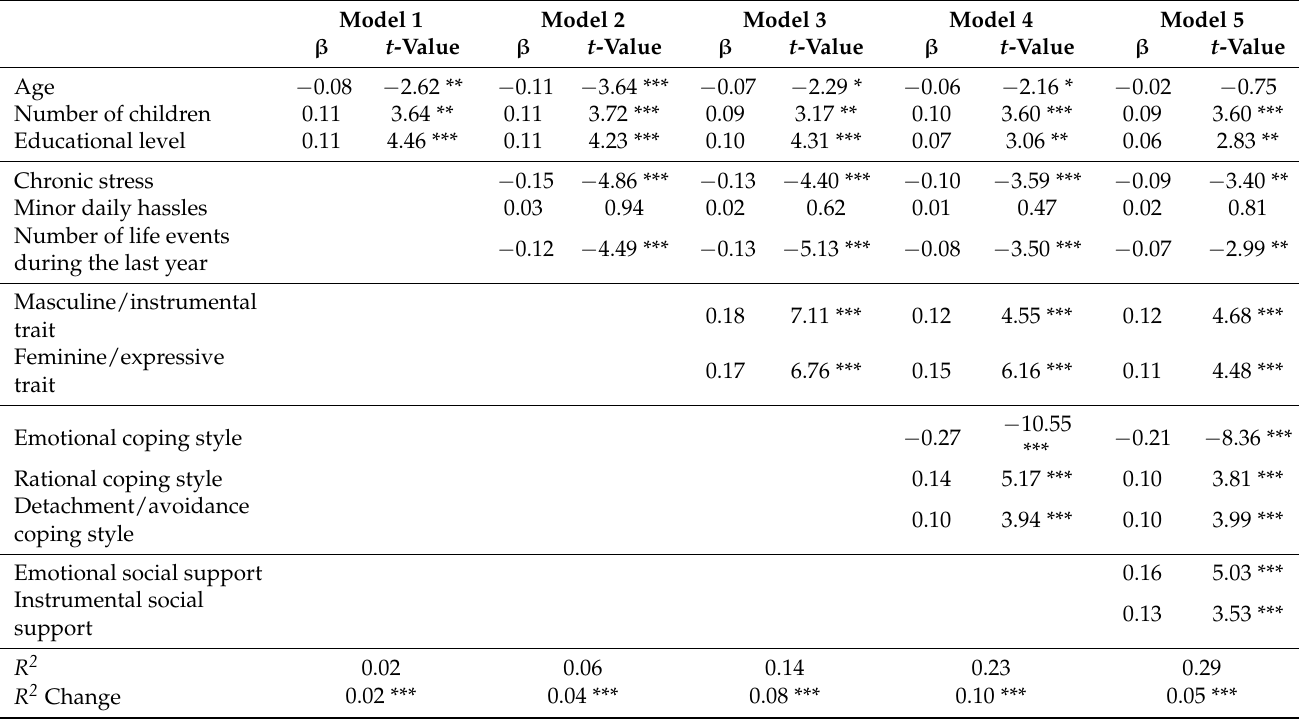
Table 6. Summary of the hierarchical regression with life satisfaction as the dependent variable for men.